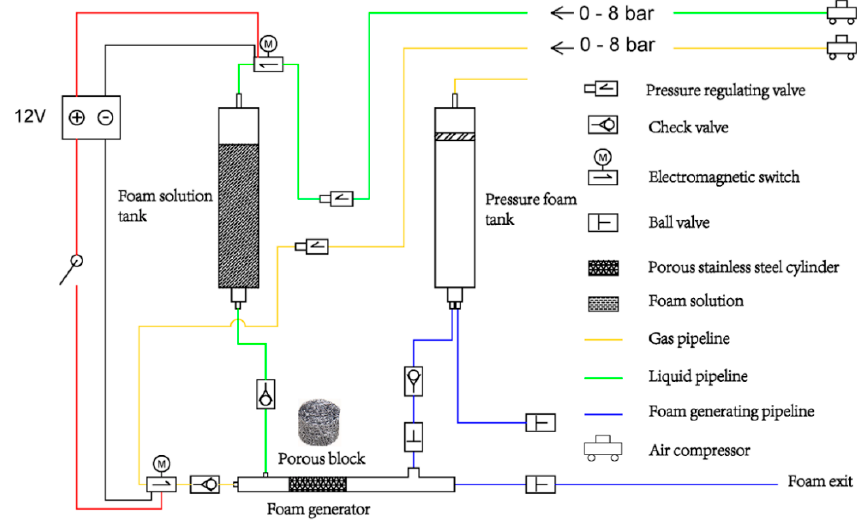
Figure 1. Structural diagram of the foam generating device.